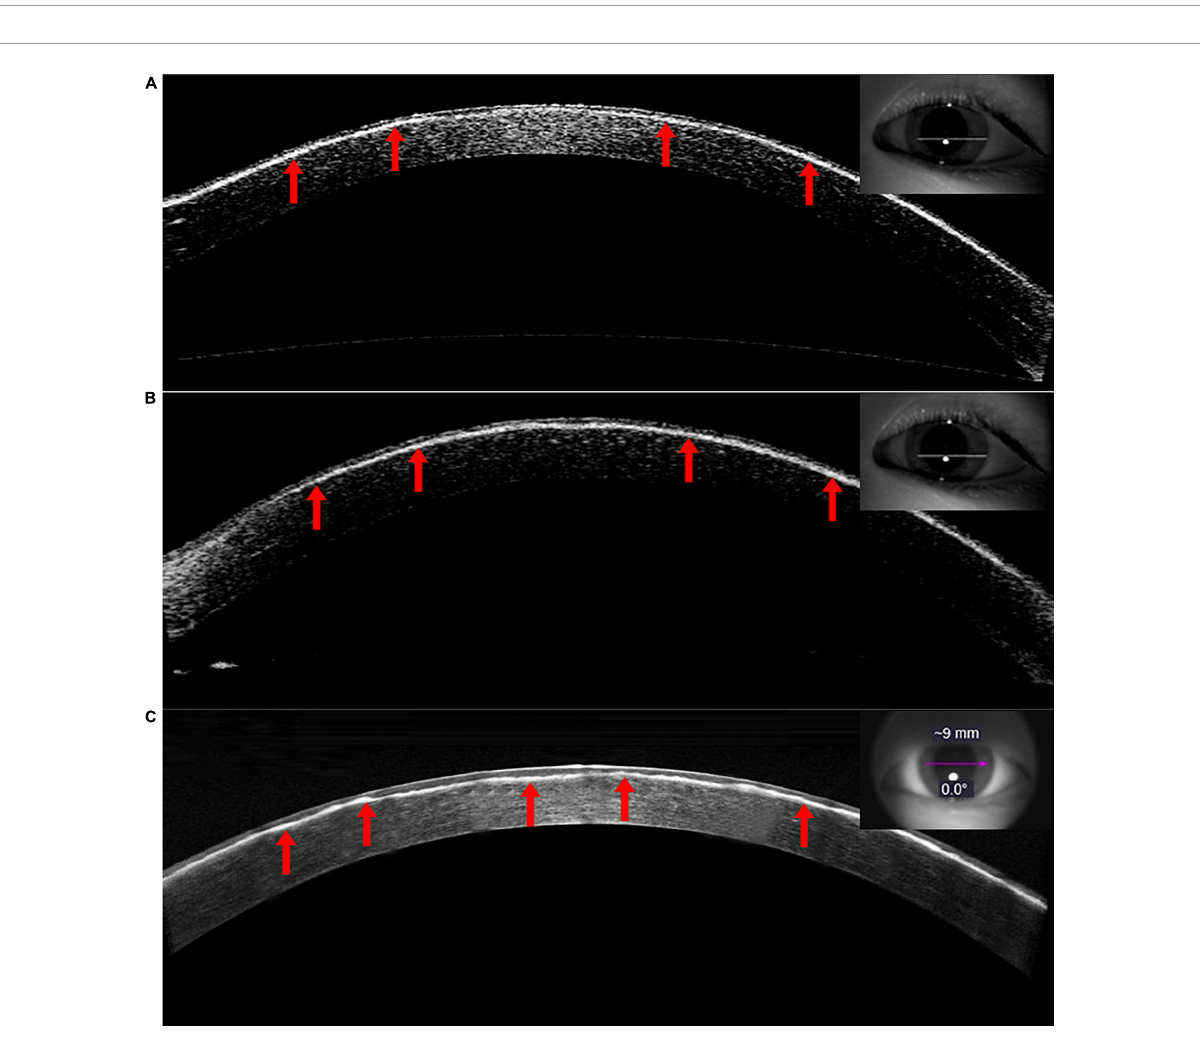
FIGURE3 A depiction of the AS-OCT (Carl Zeiss Meditec, Jena, Germany) imaging of the left eye (VI:1). Patient (A) was 12 years of age with a medical history of 10 years. Uneven thickness of the corneal epithelium was observed. The Bowmanen layer had disappeared and the anterior corneal stroma was highly reflective, with an overall irregular morphology and multiple highly reflective ridges (Visante). Patient (B) was 15 years of age with a disease history of 13 years. The interlamellar highly reflective material increased gradually over time (Visante). Patient (C) was 17 years of age with a disease history of 15 years and recurrence 2 years after PTK. The corneal interlaminar deposits were similar to those in the initial case. Superficial corneal stroma ridges were more obvious in this presentation